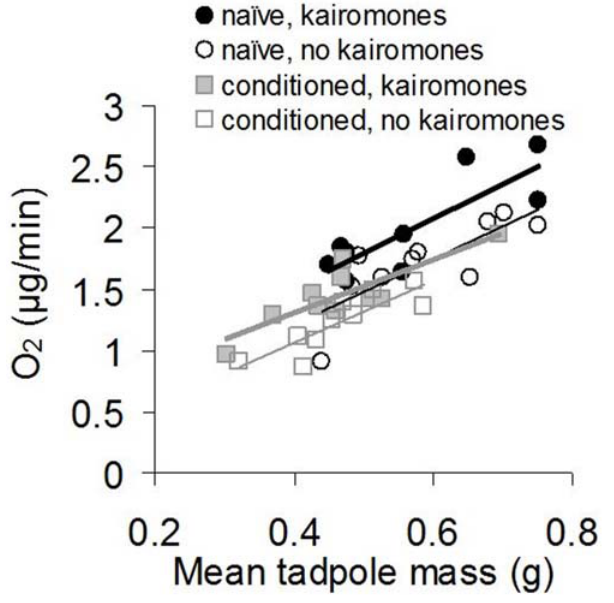
Figure 1. Relationship between oxygen consumption and tadpole mass for conditioned and naı¨ve tadpoles measured in environments with and without kairomones. Each point is the average of three tadpoles measured during three 4-minute intervals.